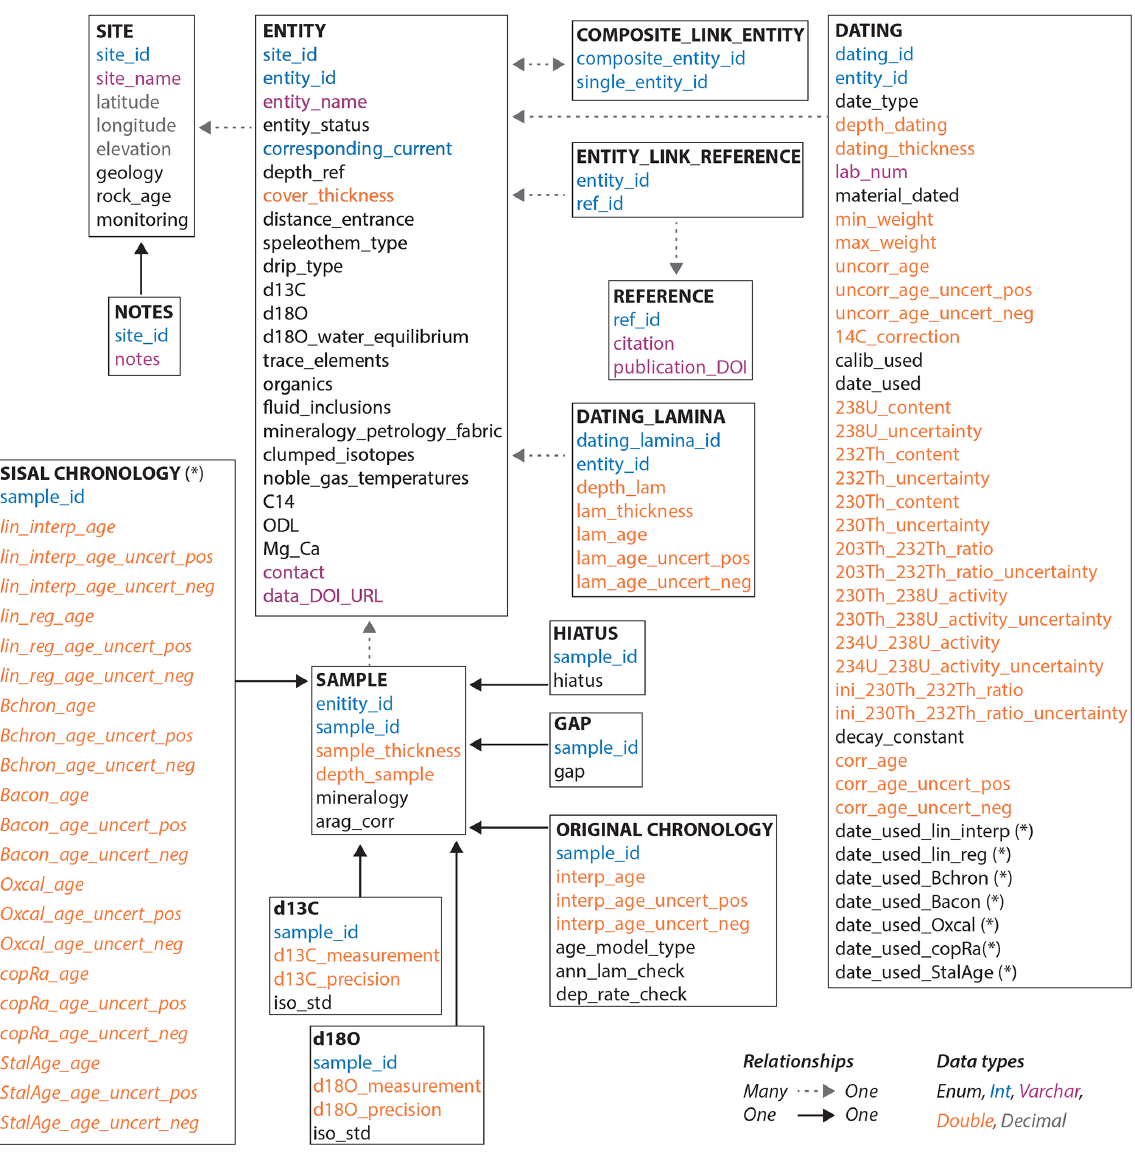
Figure 3. The structure of the SISAL database version 2. Fields and tables marked with (*) refer to new information added to SISALv1b; see Tables 1 and 2 for details. The colours refer to the format of that field: Enum, Int, Varchar, Double or Decimal. More information on the list of predefined menus can be found in Atsawawaranunt et al.